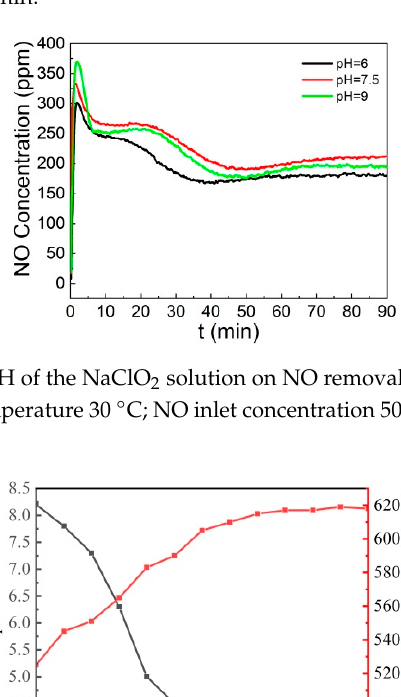
Figure 5. Effect of the pH of the NaClO 2 solution on NO removal efficiency. Reaction conditions: NaClO 2 concentration 0.01 mol/L; temperature 30 °C; NO inlet concentration 500 ppm; N 2 balance, with a total flow rate of 1.5 L/min.